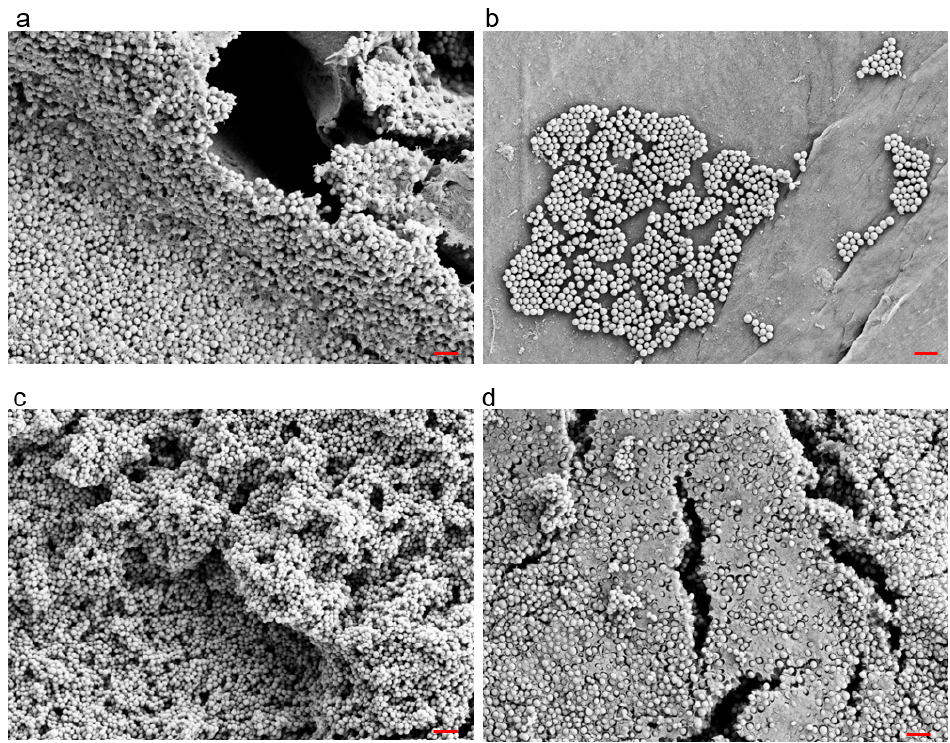
Figure 1. Example scanning electron micrographs of 2-day-old ( a , b ) and 6-day-old ( c , d ) Staphylococcus aureus biofilms grown on polyethylene discs. Red Bar = 3 μ m.